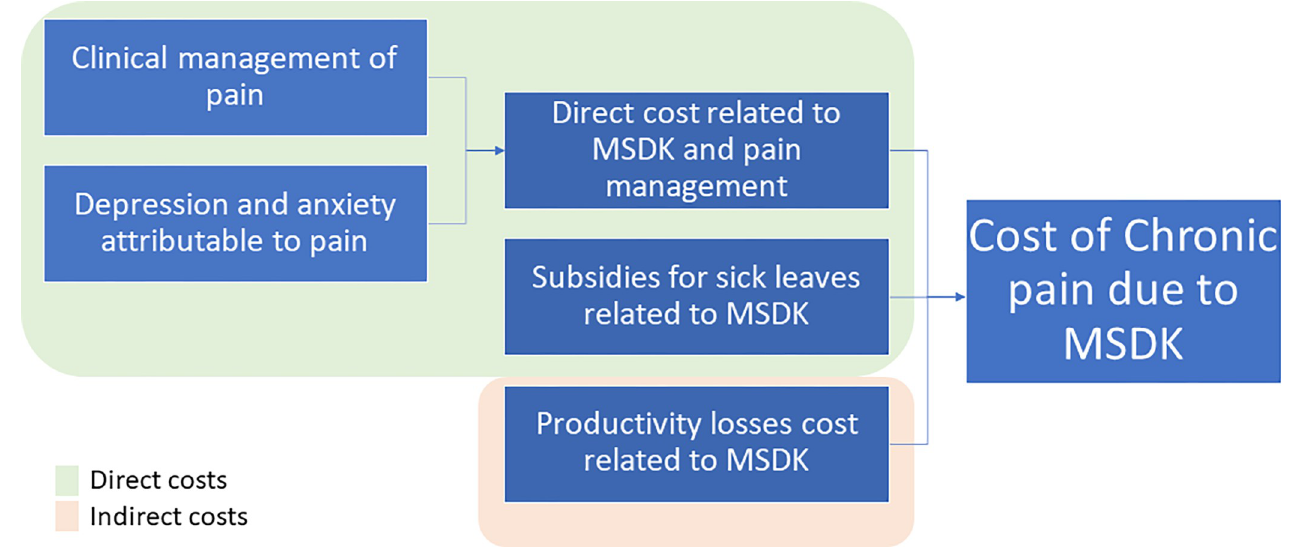
Fig 2. Dimensions of Costs related to MSKD and chronic